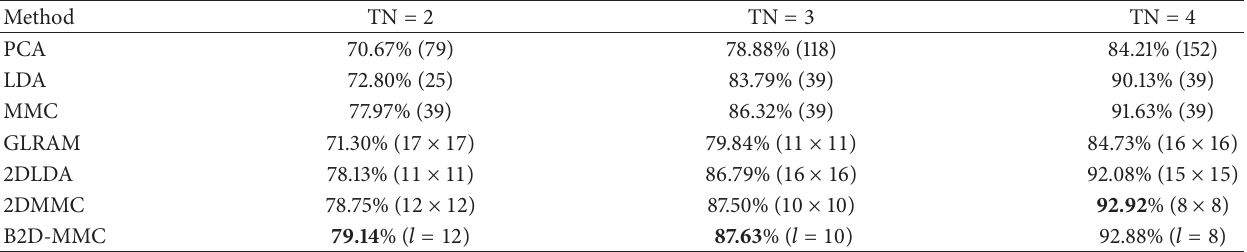
Table 1: Face recognition accuracies of different methods on the ORL database. TN means number of training samples per subject, and the number in brackets is the corresponding projection dimensionality. The bold value means the highest accuracy among all the methods.